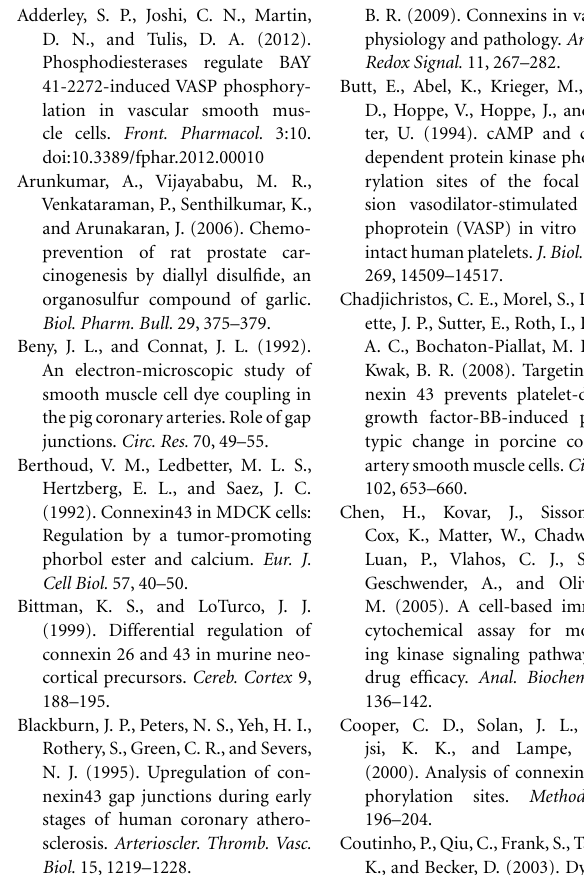
Figueroa,X.F.,andDuling,B.R.(2009). Gap junctions in the control of vas- cular function. Antioxid. Redox Sig- nal. 11,251–266. Figueroa, X. F., Isakson, B. E., and Dul- ing, B. R. (2006). Vascular gap junc- tions in hypertension. Hypertension